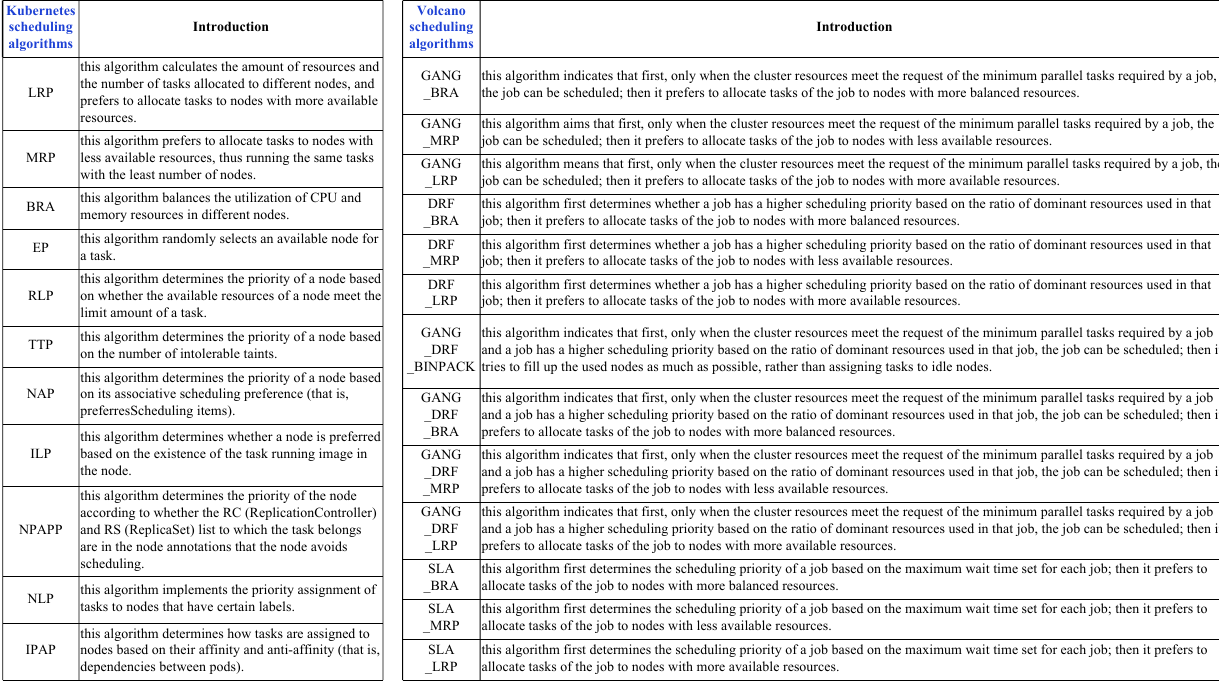
Figure 7. Description of 11 Kubernetes scheduling algorithms and 13 Volcano scheduling